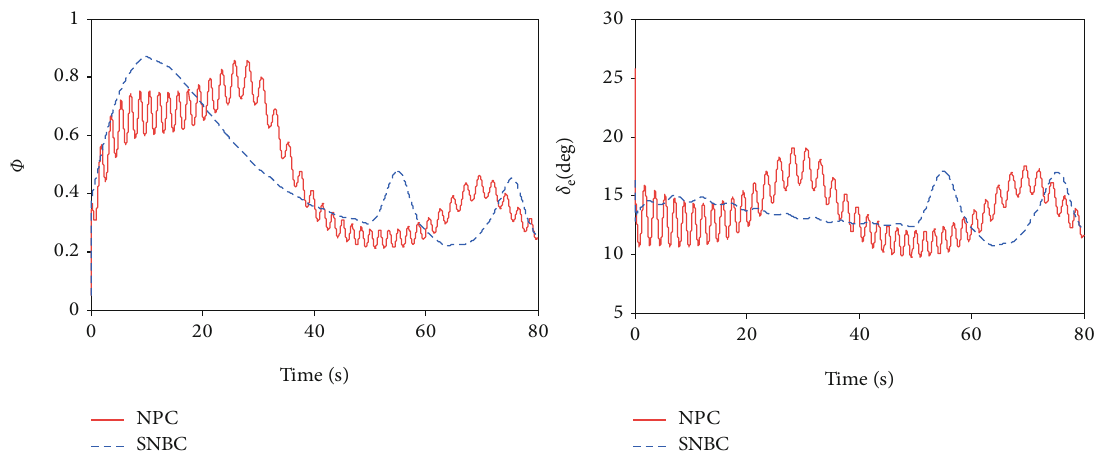
Figure 8: The control inputs of the case.